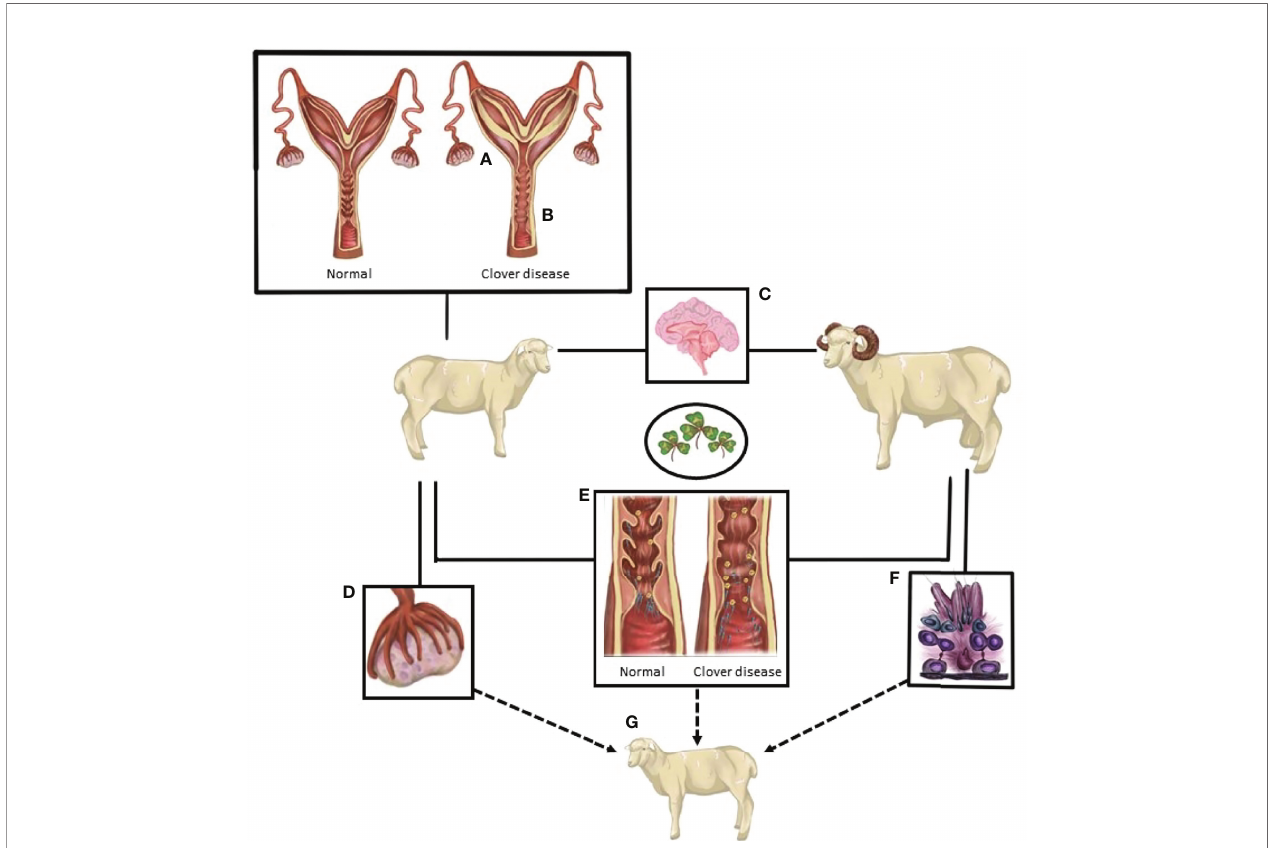
FIGURE 1 | A summary of the known and postulated sites of action of compounds from oestrogenic pasture that lead to compromised sheep reproduction. (A) Endometrial thickening/edema. (B) Loss of cervical folds. (C) Excessive oestrogen-like actions in the neuroendocrine control of reproduction. (D) Follicle development, quality and potentially ovulatory ability are reduced. (E) The interaction between spermatozoa and the female tract is altered. Loss of cervical crypts, changes in mucus composition, and consistency and changes in the female immune response hinder sperm navigation of the female tract. (F) Sperm production and quality is potentially reduced. (G) Exposure of both male and female gametes, and the ovine embryo, may cause differential developmental programming of the subsequent